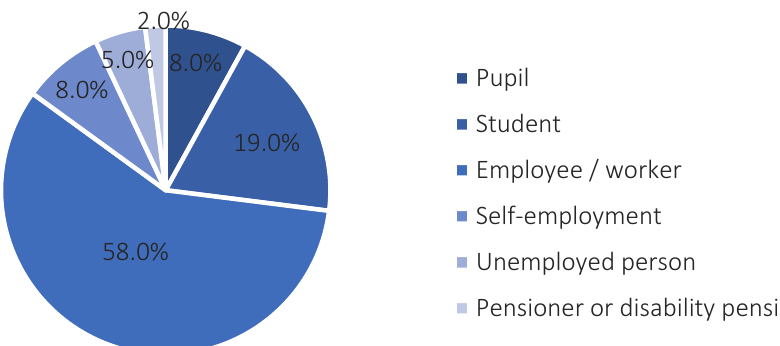
ents’ professional situation is provided in Figure 8.